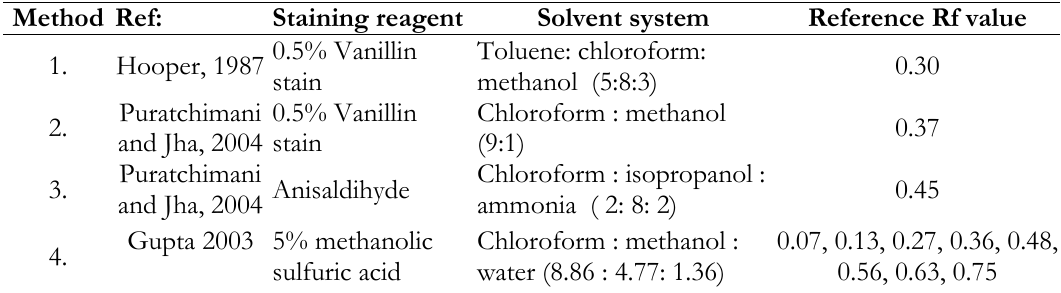
Table I. Methods for extraction of gymnemic acid and solvent system for TLC. Method